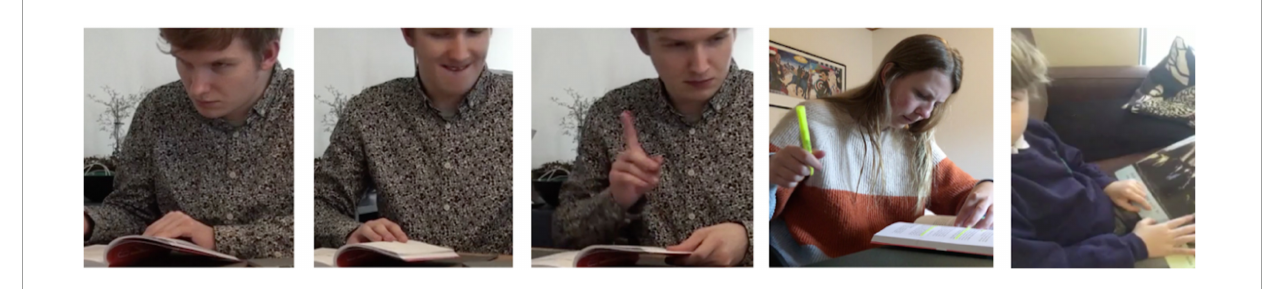
FIGURE1 Gallery of readers’ self-initiated micro breaks in reading that are part of